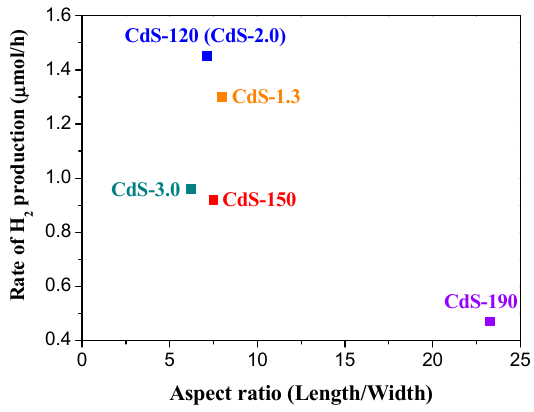
Figure 10. Comparison between hydrogen production rate and the aspect ratio (length/width derived from TEM) of the CdS samples.